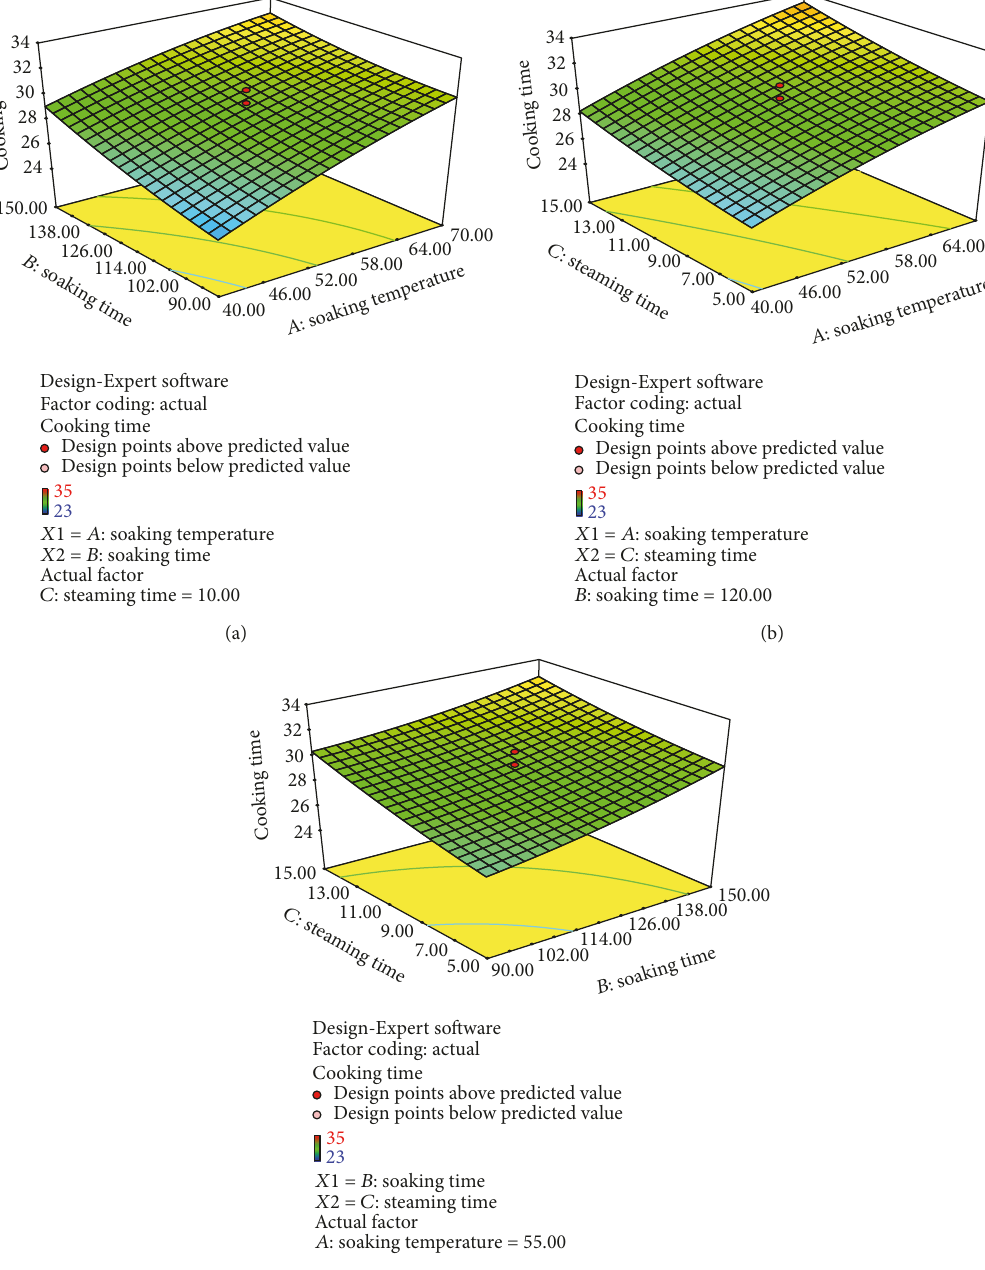
Figure 4: The cooking time affected by soaking temperature, soaking time, and steaming